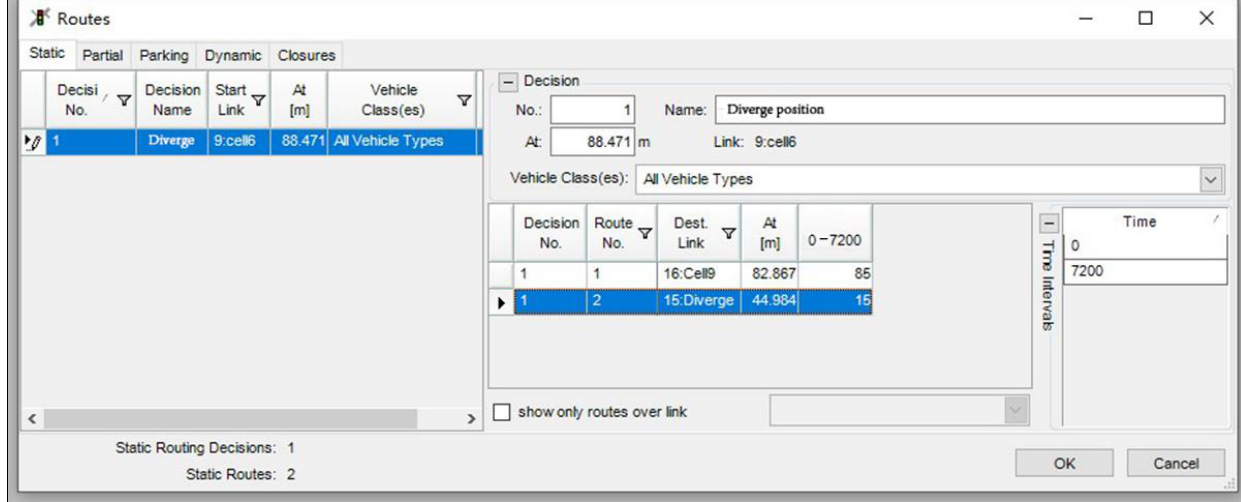
Figure 12. Diverge area path decision setting. Table 1. Simulation vehicle composition input.